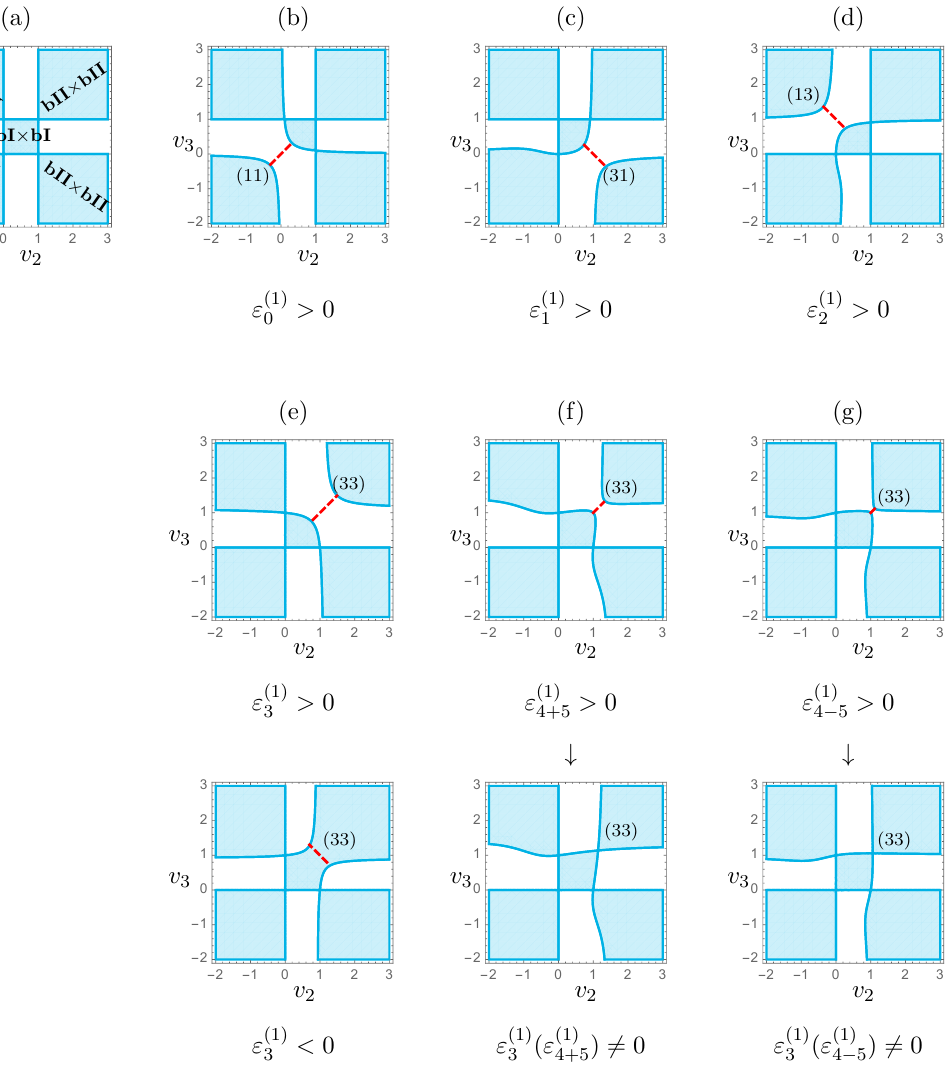
Figure 3 . Hypersurface equation (2.20) in the ( R -projected) ( v 2 ; v 3 ) plane for various Z (1)